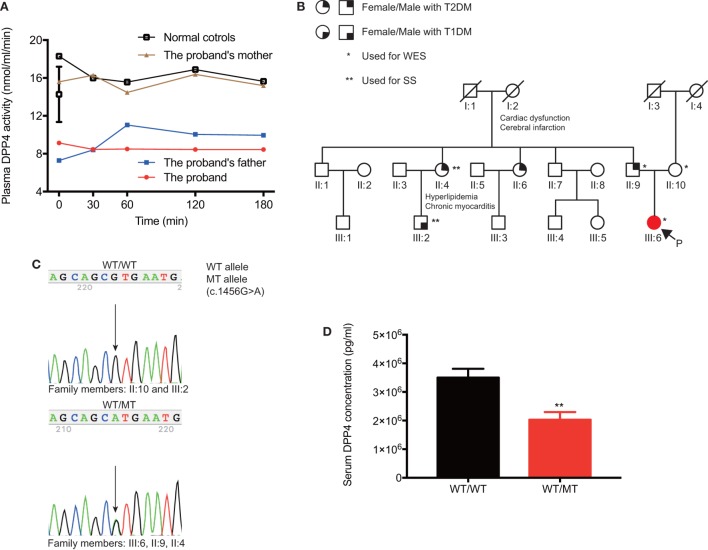
Clinical features and genetic information of DPP4 in the pedigree. (A) The comparison of plasma DPP4 activity between the proband and her parents. (B) Family members are designated by Arabic numerals. Horizontal lines between individuals represent marriage. Vertical lines represent lineage. The individual’s current clinical diagnosis and genotypes are provided if the blood samples were available. (C) Sanger sequencing was applied to verify genotypes, and representative chromatograms are shown. Individuals who are heterozygous for the p.V486M (c.1456 G>A) mutation showed overlapping A and G peaks. (D) Comparison of serum DPP4 concentrations between the mutation carriers and non-mutation controls. Data were expressed as mean ± SEM. **P-value <0.01. DPP4, dipeptidyl peptidase IV; T1DM, type 1 diabetes; T2DM, type 2 diabetes; WES, whole-exome sequencing; SS, sanger sequencing; P, the proband; WT, wild-type; MT, mutant-type.